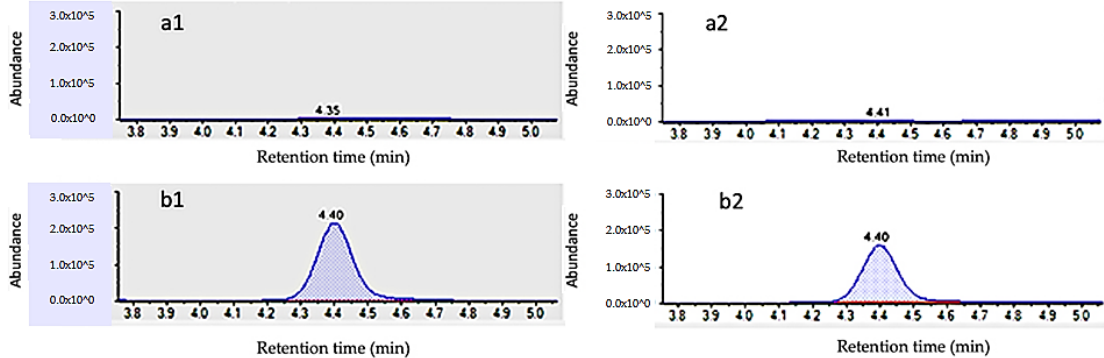
Figure 3. UHPLC–MS/MS chromatogram of ( a ) blank orange sample, monitoring transitions at m/z 219/161 ( a1 ) and m/z 220/163 ( a2 ), and (b) blank orange sample spiked with 10 µg/kg of 2,4-D, monitoring transitions at m/z 220/161 ( b1 ) and m/z 220/163 ( b2 ).